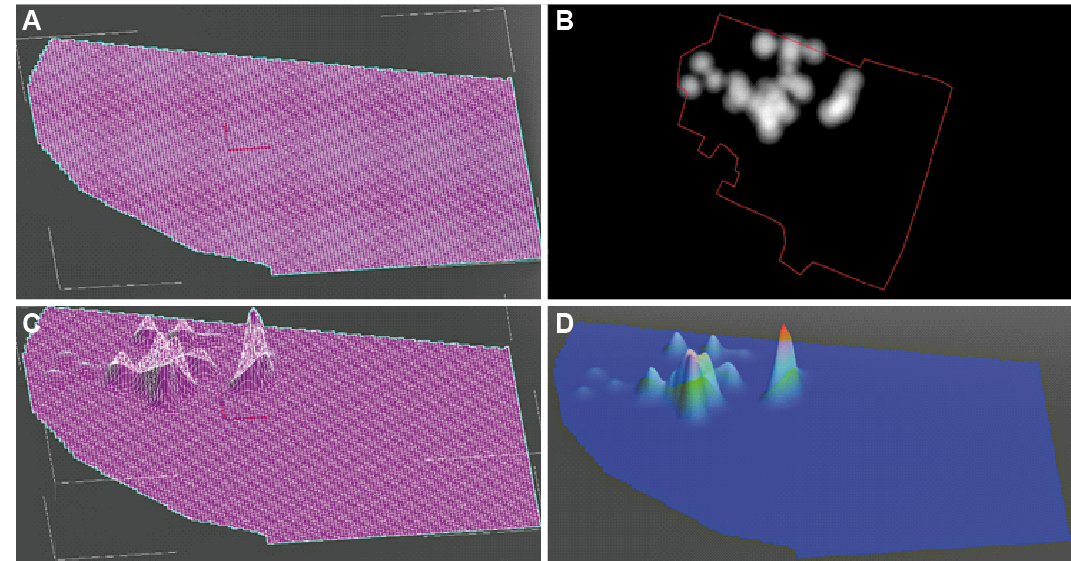
Figure 8. The process of creating a 3D heatmap in 3dsmax. ( A ) Fine retopologization of the plane intended to undergo the displace modifier; ( B ) black and white image used for the displace, with contour for recalibration on site; ( C ) application of the displace modifier; ( D ) application of a material with a gradient (diffuse map) and an opacity map using a planar UVW map